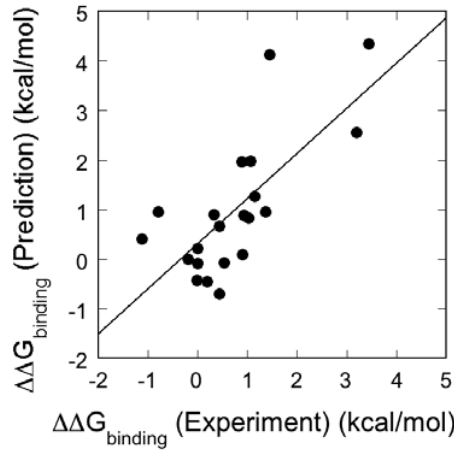
Figure 1. Prediction of the changes in free energy for the formation of protein-phosphopeptide complexes upon muta- tion of protein residues in the environment of the phosphate group. The fitted line has a correlation R-value of 0.72 and a slope of 0.91.